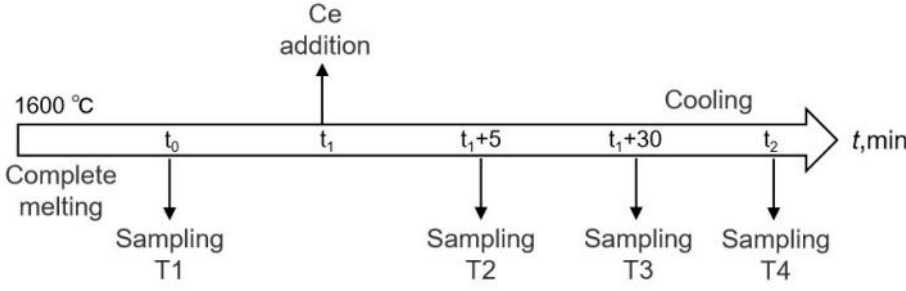
Figure 2. Schematics of rare earth addition and steel sampling times in experiment.